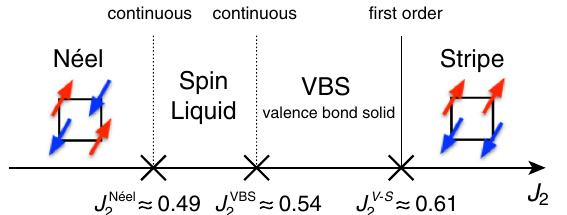
FIG. 1. Ground-state phase diagram of square-lattice J 1 - J 2 Heisenberg model ( J 1 ¼ 1 ) obtained by the RBM þ PP method.